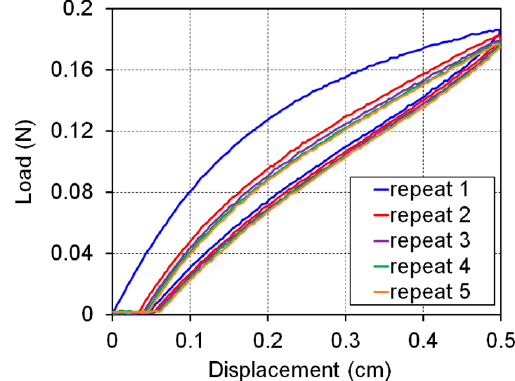
Figure 3. Change in the stress applied to the fabricated PU membrane depending on the strain (stage moving speed: 100 µ m/s).